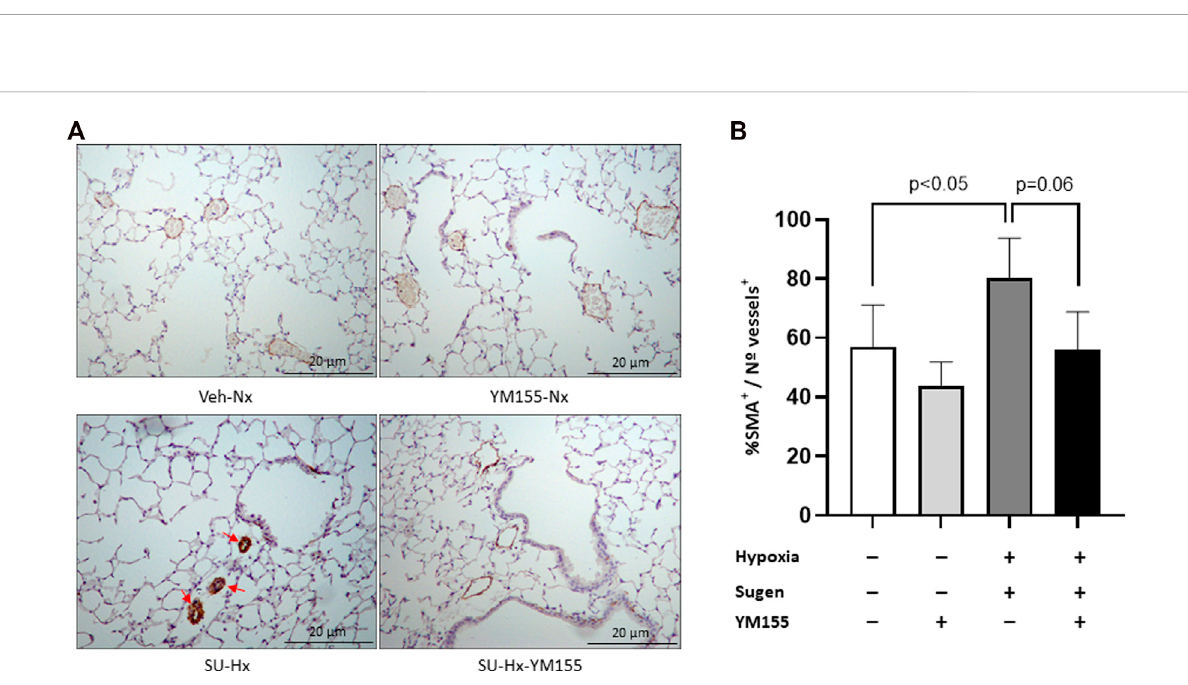
FIGURE 3 Effect of YM155 on pulmonary vascular remodeling in SU5416/hypoxia-induced PAH mice. (A) Representative α -smooth muscle actin ( α -SMA) stained pulmonary arterioles in the different experimental groups (Veh-Nx = vehicle and normoxia; YM155-Nx = vehicle, normoxia and YM155; SU-Hx = SU5416 and hypoxia; SU-Hx-YM155 = SU5416, hypoxia and YM155). (B) Percent of α -SMA positive arteries with respect to the total number of vessels in each experimental group. Values are expressed as median (IQR) and statistical signi fi cance was assessed by the Kruskal – Wallis test. Arrows indicate muscularised small pulmonary arteries strongly immunostained with alpha α -SMA